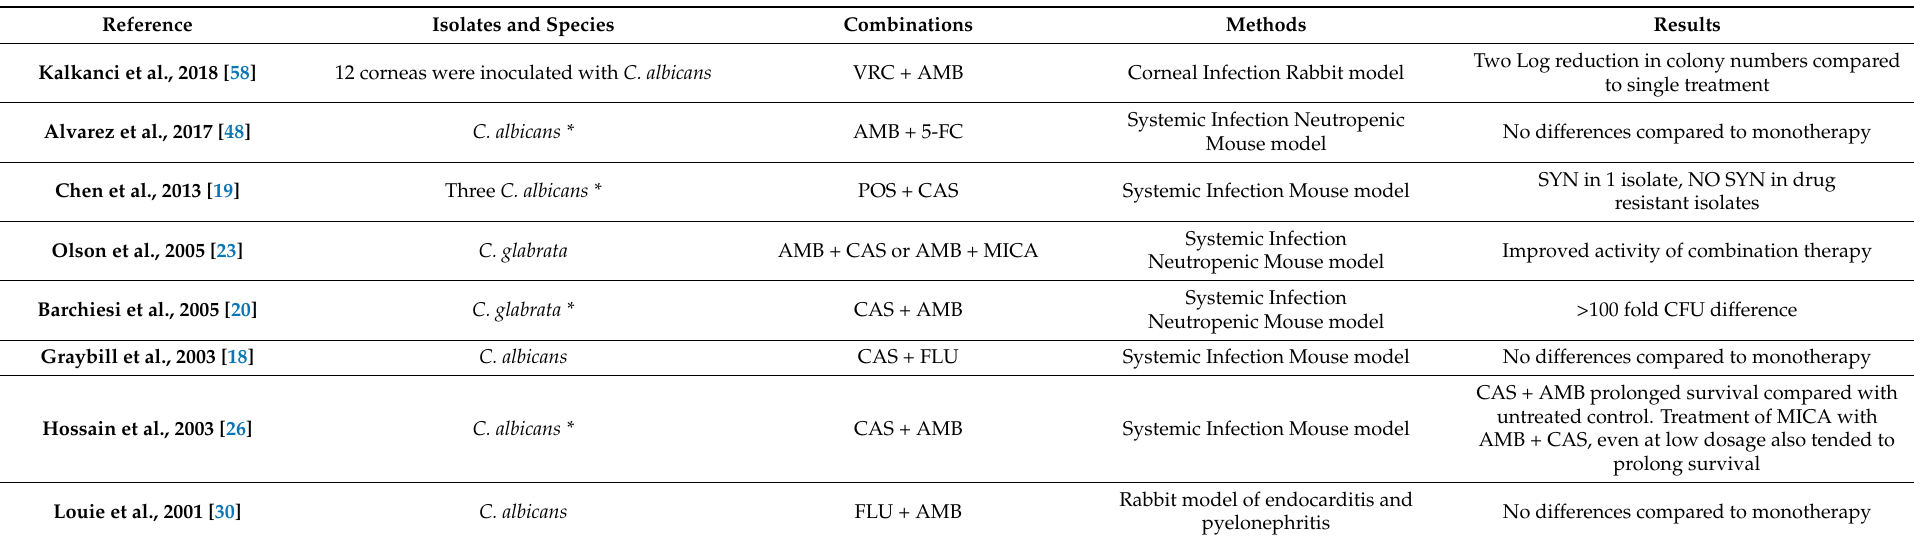
Table 2. Reports of antifungals combinations in experimental animal model of